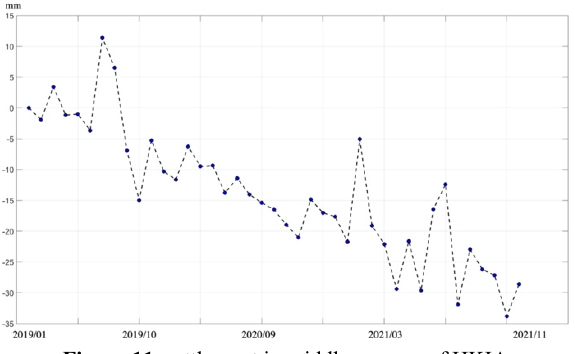
Figure 11 . settlement in middle runway of